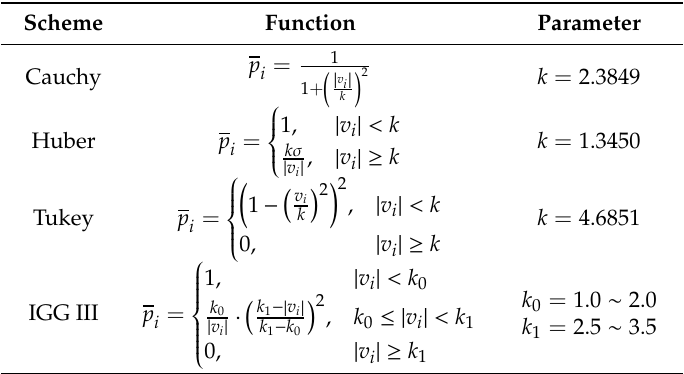
Table 1. Four representative score functions.